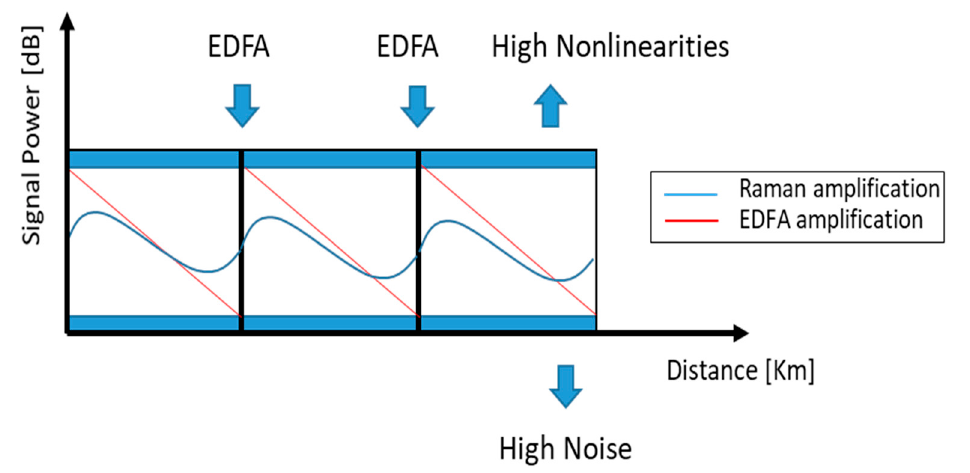
Figure 4. Ideal distributed amplifier: the loss is counterbalanced at every point along the span, leading to an improvement of the signal to noise ratio (SNR) respect to (ideal) discrete amplification.